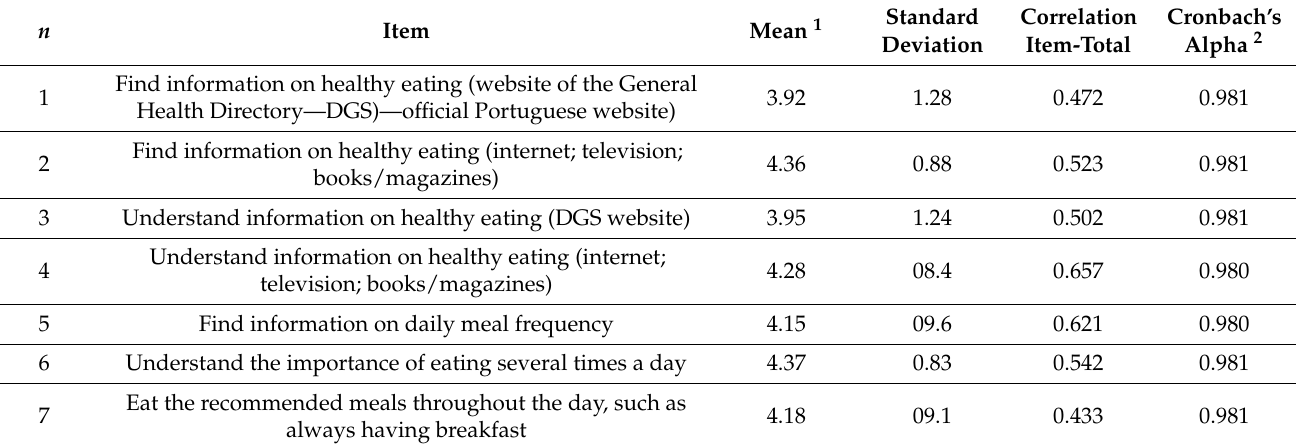
Table 4. Statistics relatively to all scale items and and internal